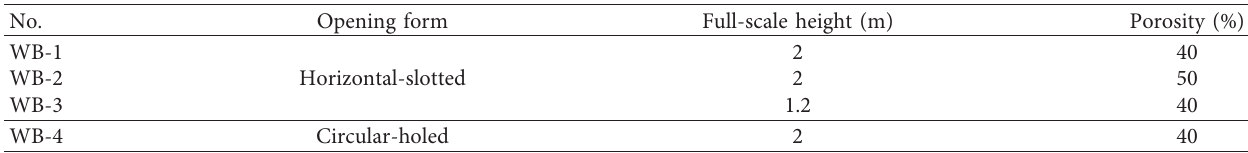
Figure 5: Sketches of wind barriers used in wind tunnel tests (units: mm): (a) circular-holed barrier; (b) horizontal-slotted barrier. Table 1: Parameters of different wind barriers at full